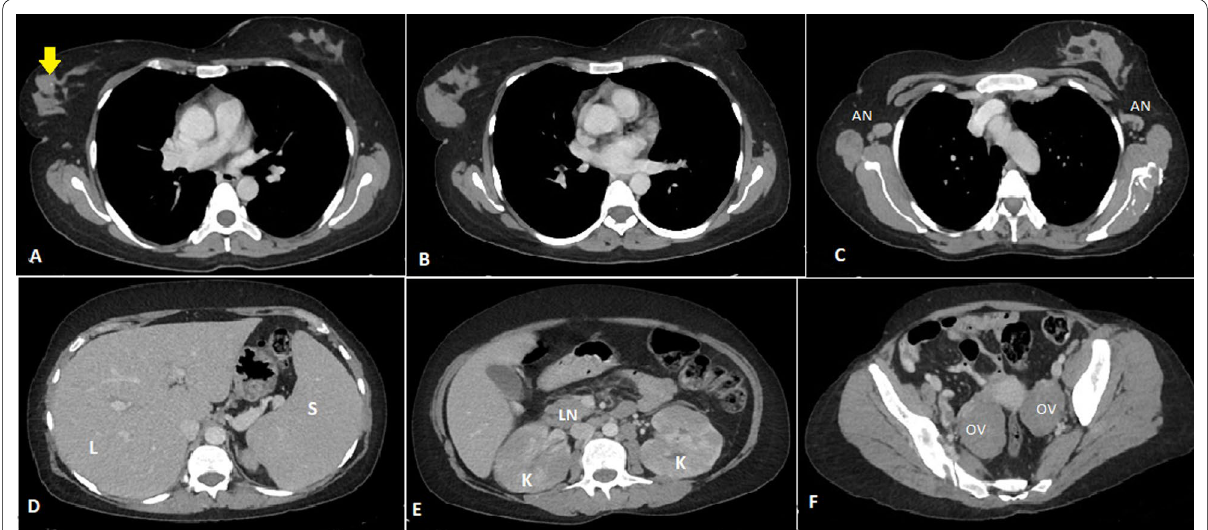
Fig. 1 Post IV contrast CT scan axial slices of a 40-year-old female showing a a rounded ovoid mass in the right breast (yellow arrow), b, c bilateral dense breast parenchyma and enlarged axillary lymph nodes (AN), d enlarged liver (L) and spleen (S), e enlarged globular hypodense kidneys (K), upper abdominal lymphadenopathy (LN) and f enlarged bilateral hypodense ovaries (OV)